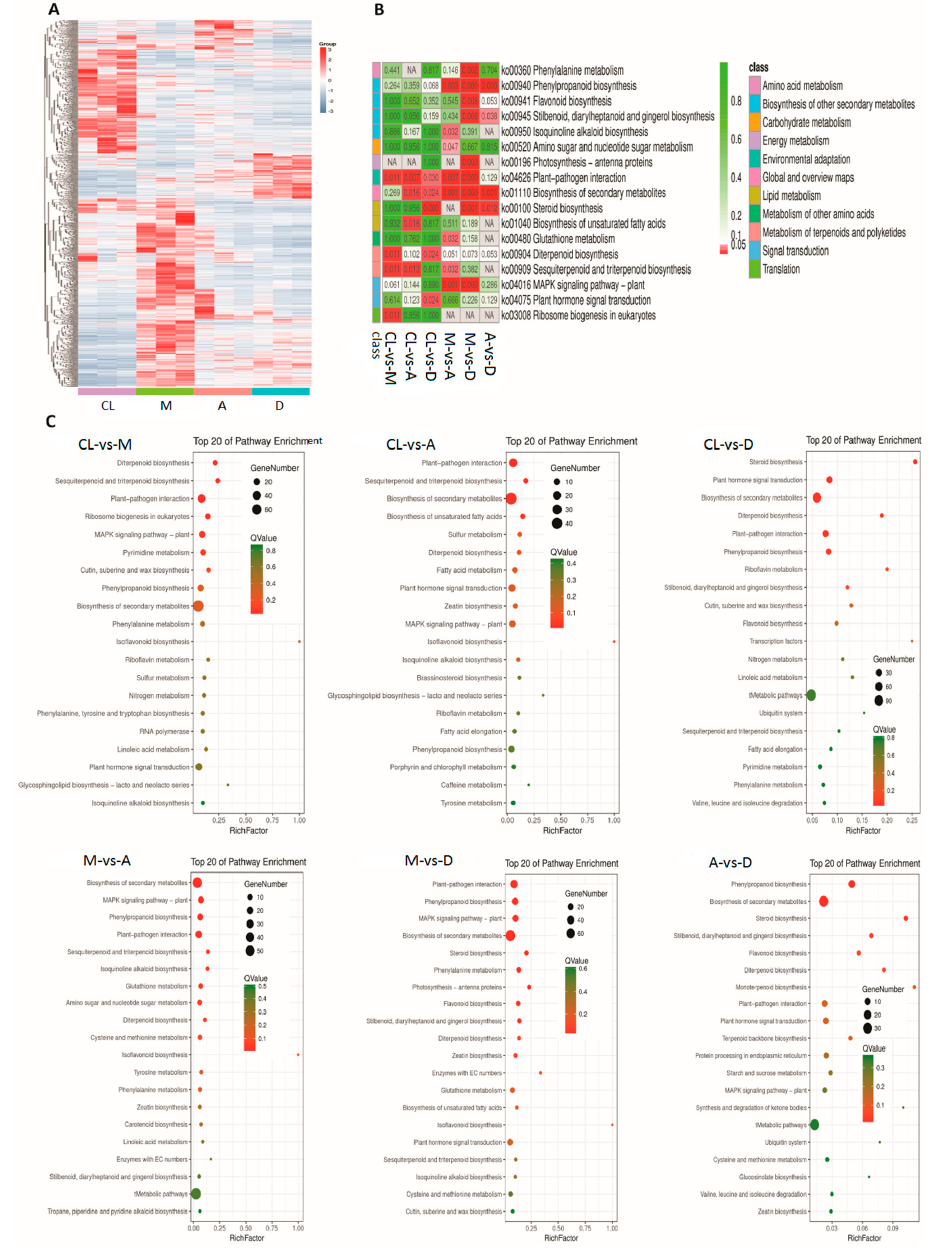
Figure 5. Gene expression patterns between DL treatments and control and KEGG enrichment analysis. ( A ) Global gene expression patterns between control and treatments. ( B ) Q-value heatmap of KEGG enrichment. ( C ) KEGG pathway enrichment analysis between control and DL treatments. RichFactor refers to the ratio of the number of transcripts in the pathway entry in the di ff erentially expressed transcript to the total number of transcripts in the transcript that are located in the pathway entry. The larger the RichFactor, the higher the degree of enrichment is. The dot size indicates the number of DEGs of the pathway, and the dot colour indicates the